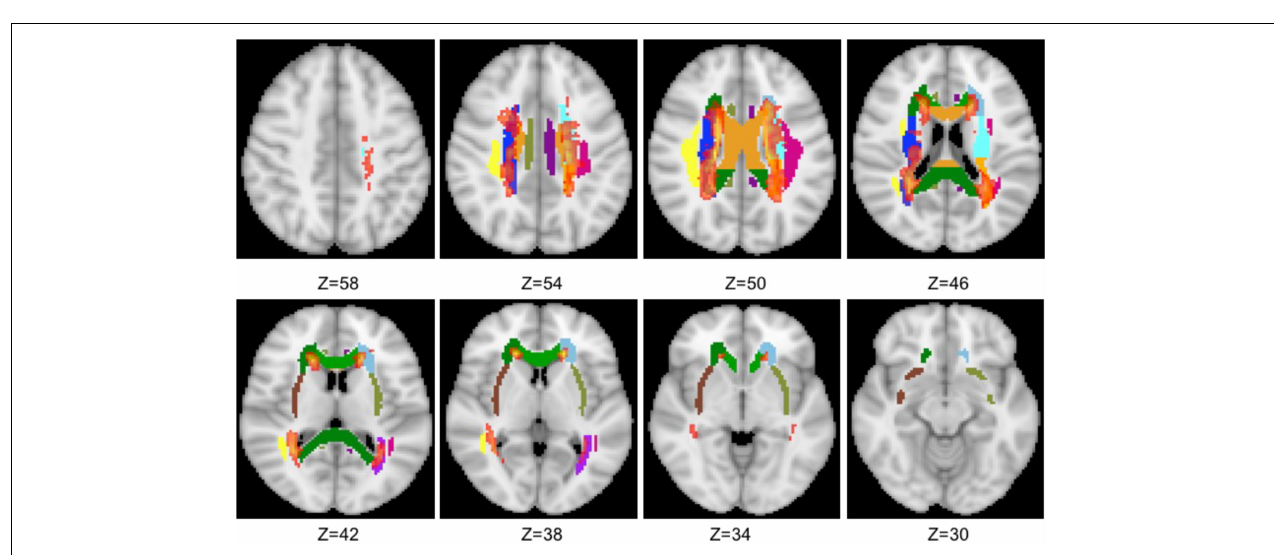
FIGURE 2 | Overlaying the probabilistic lesion map (hot color, threshold 0.3) on the NAWM tracts. The other colors represent the same WM tracts as in Figure 1